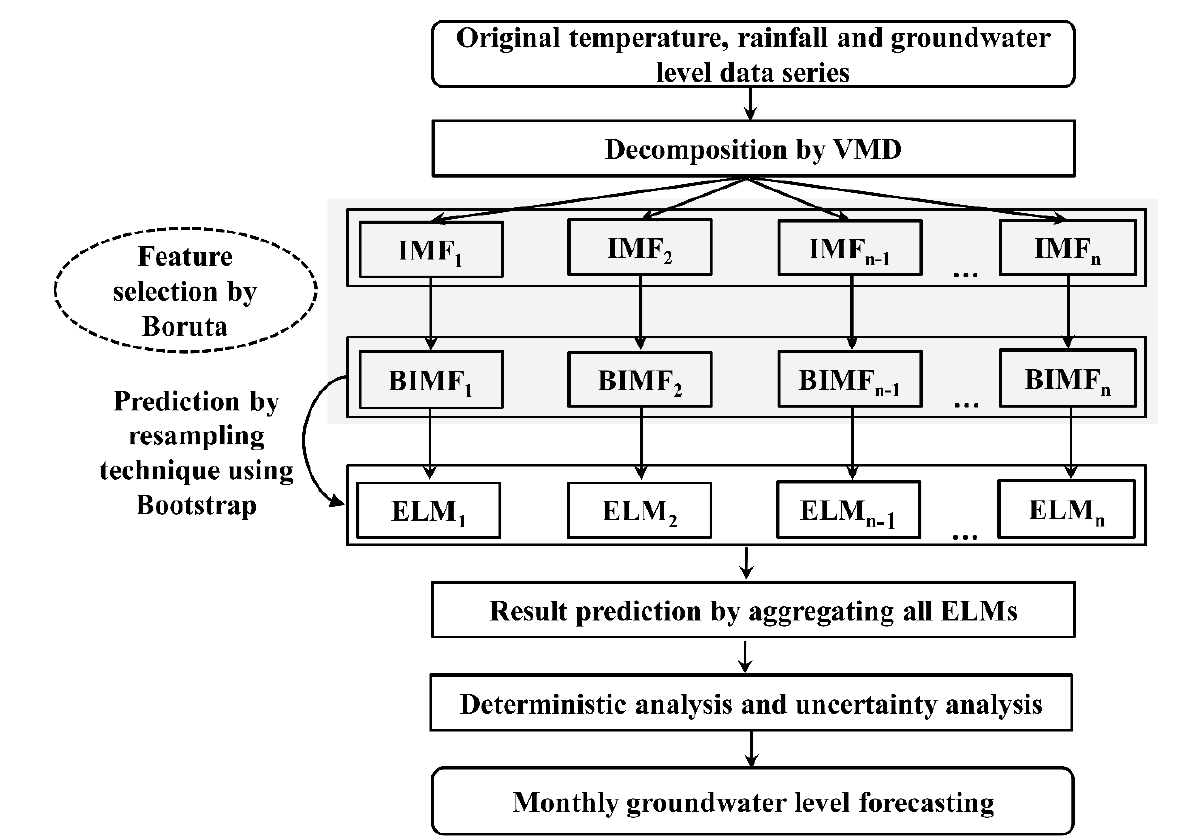
Figure 1. The schematic structure of the proposed forecasting modeling.